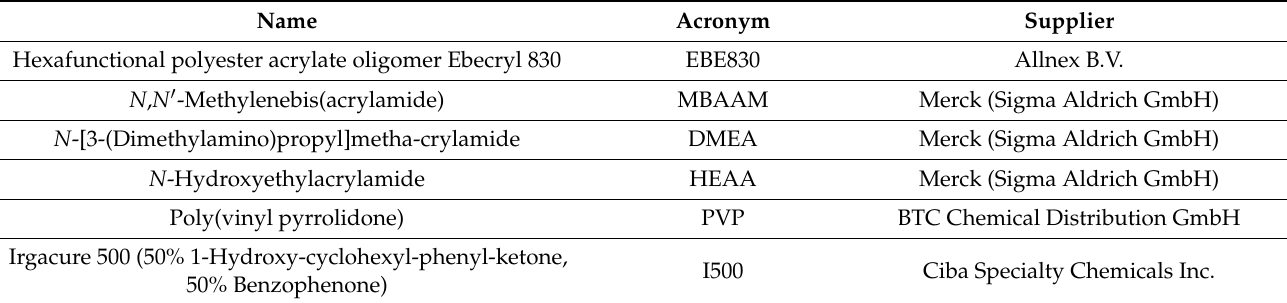
Table 1. Chemical reagents, acronyms and supplier details.